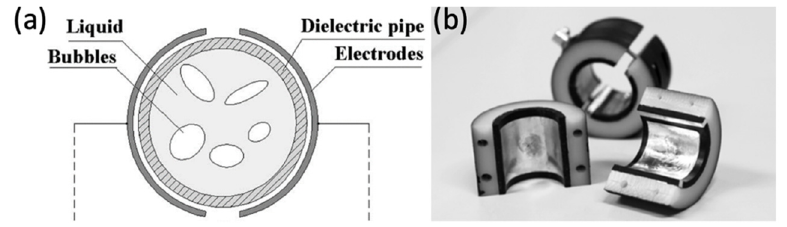
Figure 5. ( a ), The structure of a typical concave capacitance sensor, adapted with permission from [134], 2004, Elsevier and ( b ), an actual concave capacitance sensor, adapted with permission from [135], 2014, Elsevier.